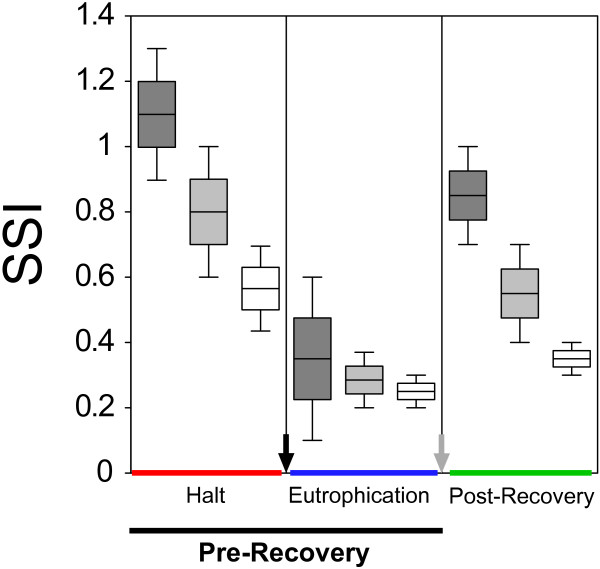
Boxplots showing the distribution of SSI (Species Specialization Index) in different periods (Halt, Eutrophication, Post-recovery). Dark grey boxes are for basin 1, light grey boxes for basin 2, and white boxes for basin 3. The black arrow indicates the first algal bloom and grey arrow the start of recovery actions.